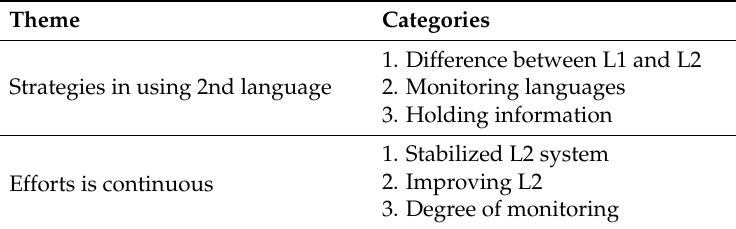
Table 5. Themes and categories used in the